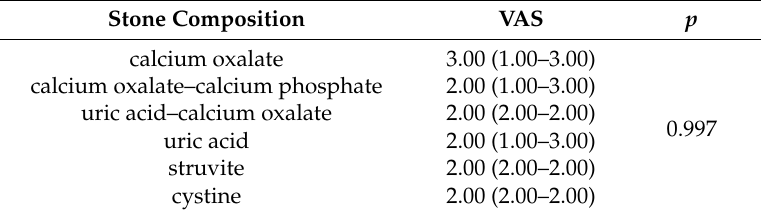
Table 6. Correlation between VAS and stone